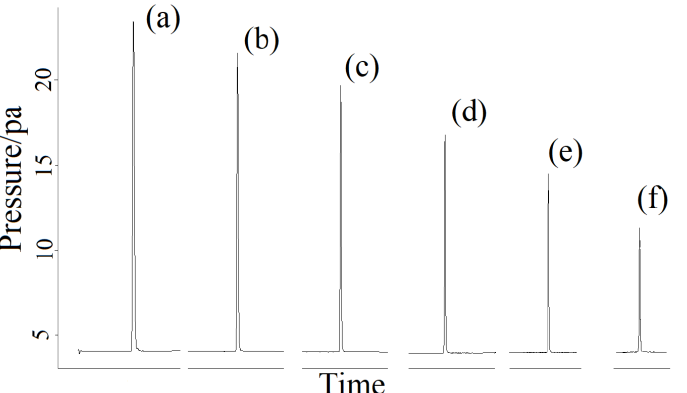
Figure 5. The average chromatographic peak of methane with different split ratios (1:1, a ; 2:1, b ; 3:1,